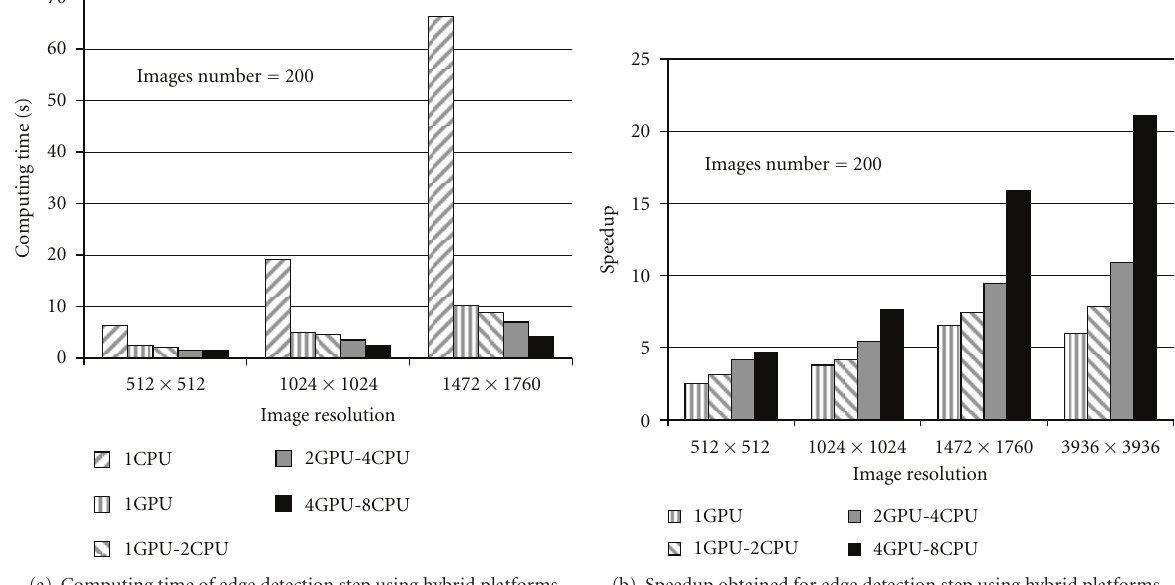
(b) Speedup obtained for edge detection step using hybrid platforms Figure 7: Performance of recurive edge detection using heterogeneous